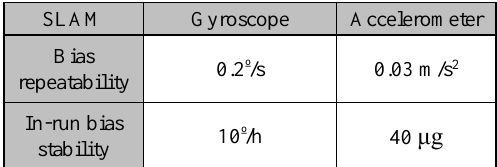
Table 1. Key specifications of the Xsens MEMS